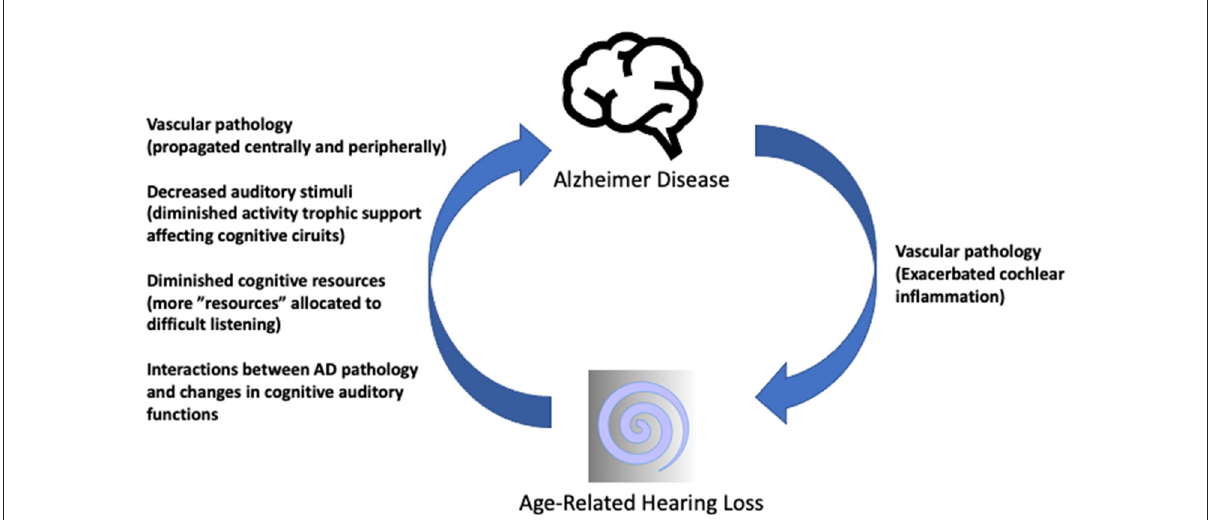
FIGURE1 Summary sketch of possible interactions between ARHL and AD. Hypothetic mechanisms of ARHL influencing AD (ascending arrow) have been covered in detail (Griffiths et al., 2020; Nadhimi and Llano, 2021). The descending arrow represents less often considered influences of AD pathology on the auditory receptor which may close the loop of a self-sustaining pathophysiological vicious circle. AD-related or pre-existing vascular pathologies may propagate to the cochlear microvasculature, exacerbating mechanisms involved in age-related “inflammaging” in